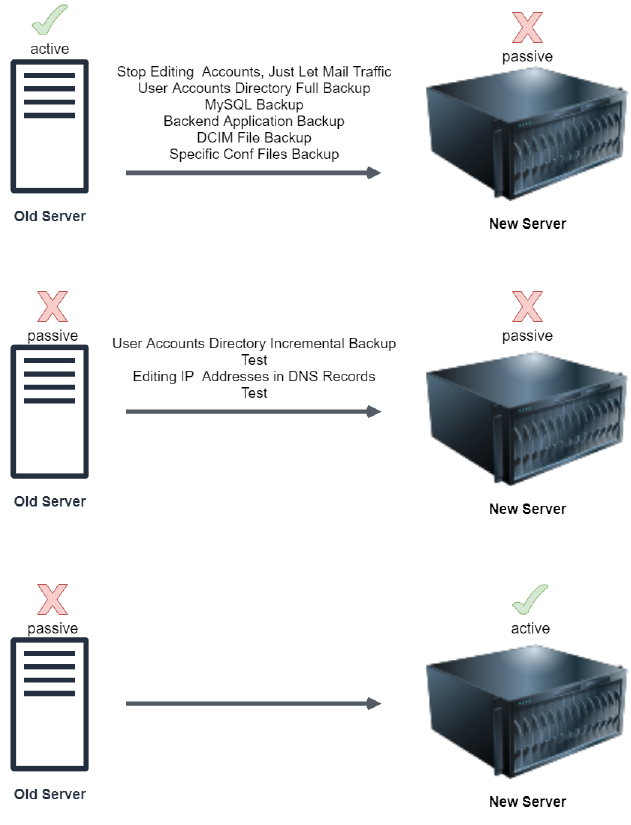
Figure 2. Steps of the server